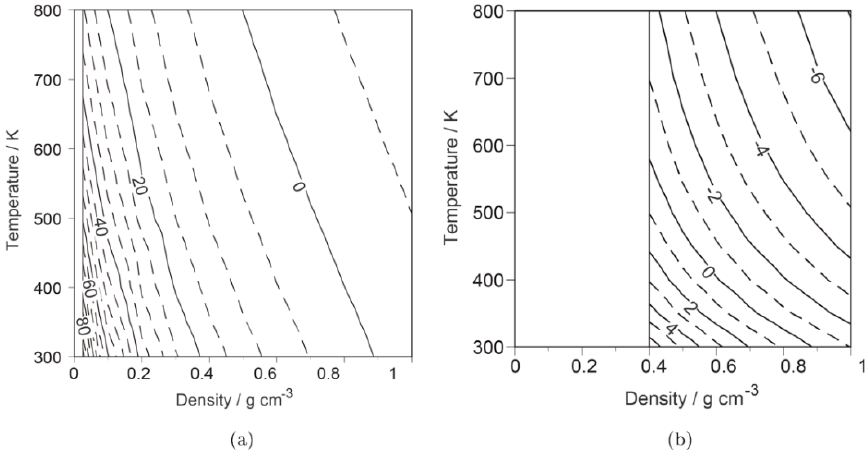
Figure 4. Density and temperature dependences of ∆ p K w , the difference of the p K w ( ρ , T ) from p K w (1.0 g cm − 3 , 273.15 K). The computational and experimental values are provided in panels ( a ) and ( b ), respectively. These figures are reprinted with permission from [26], Copyright 2014, American Chemical